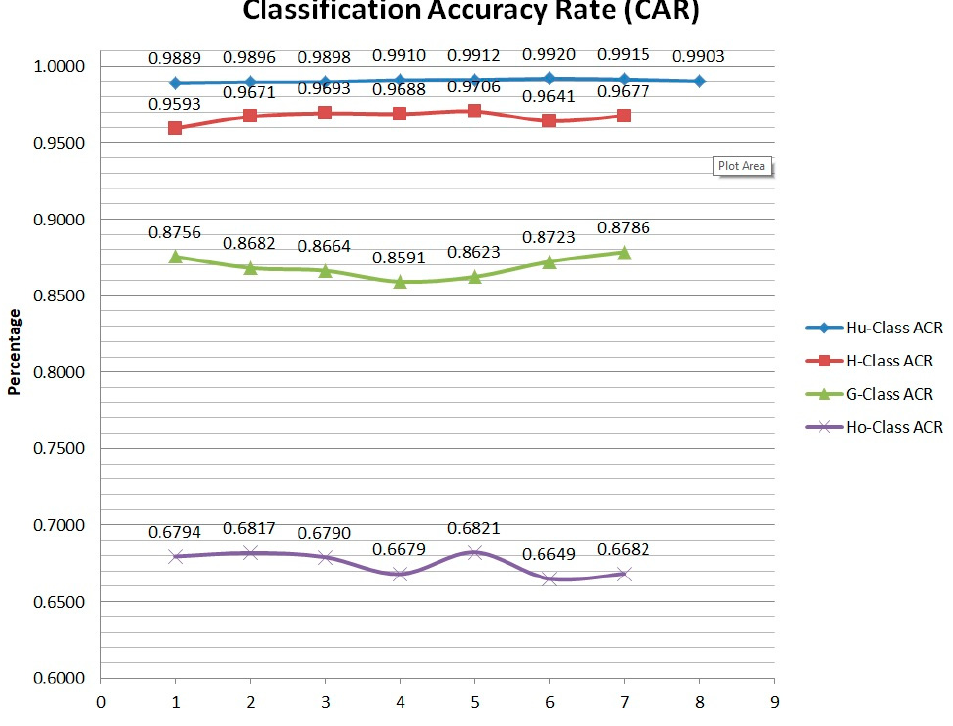
Figure 7. Error rate of CAR. 3.2. Performance of the Safety System To measure the efficiency of the proposed safety system, eight videos were used. These videos were recorded with different backgrounds such as school zones, chemical plants, and construction sites with people wearing safety equipment or not. In each video, the safety system algorithm (as in